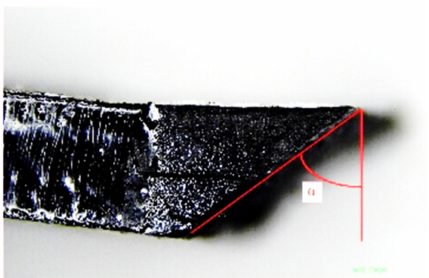
Figure 16. The fracture angles of the off-axis compression specimens.